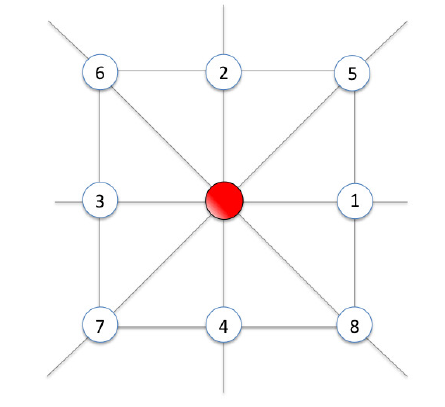
Figure 1. Sketch of a D2Q9